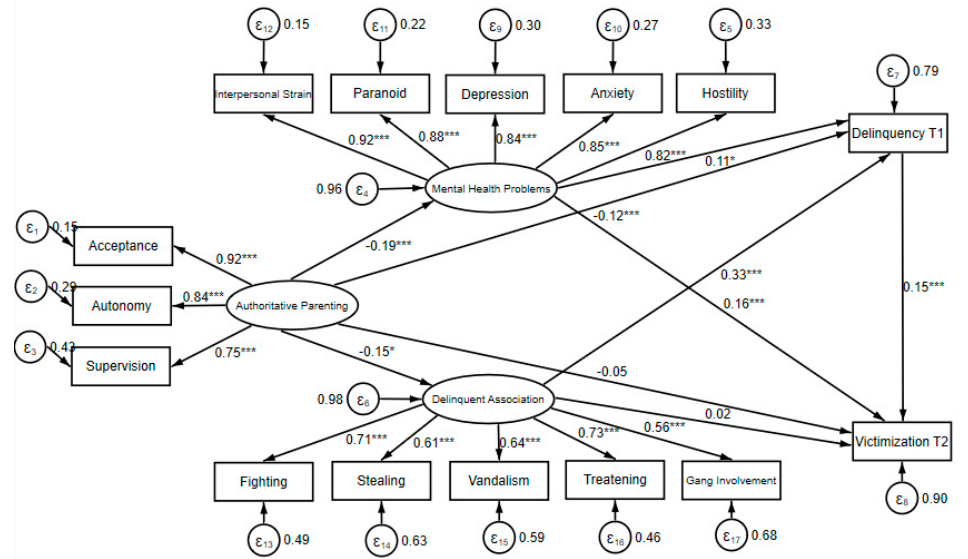
Figure 3. X 2 = 482.540, d.f. = 143, root mean square error of approximation (RMSEA) = 0.047, comparative fit index (CFI) = 0.960, Tucker–Lewis Index (TLI) = 0.949. All of the coefficients are standardized. Control variables (not shown) include gender, age, family monthly income, paternal, and maternal education level.